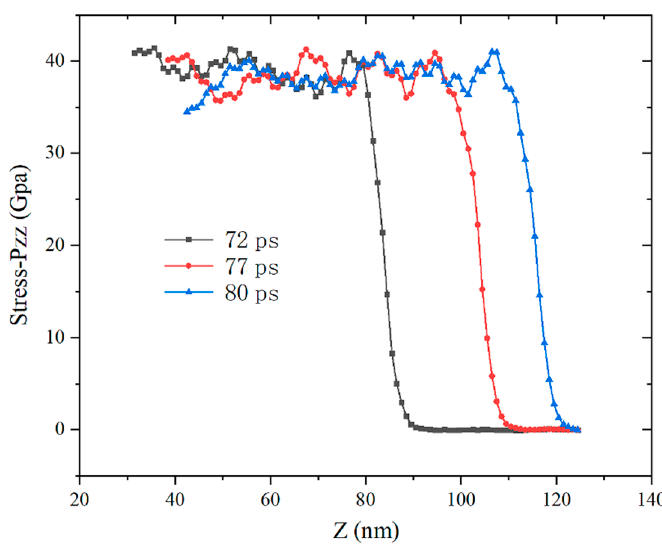
Figure 15. Impact velocity 1400 m/s stress waveform at different moments.